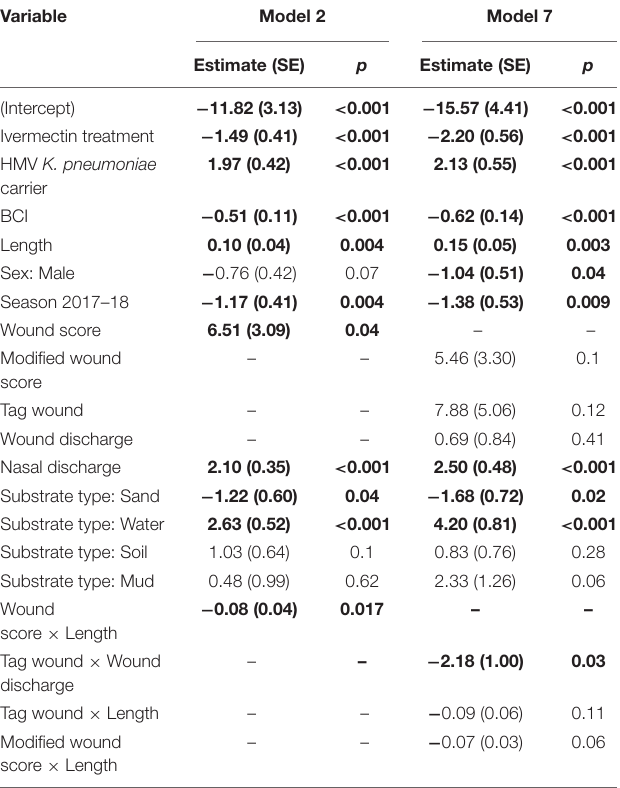
TABLE 3 | Summary results of generalized linear models 2 and 7, analyzing risk factors for hypervirulent Klebsiella pneumoniae mortality in New Zealand sea lion ( Phocarctos hookeri ) pups at Sandy Bay, Enderby Island.